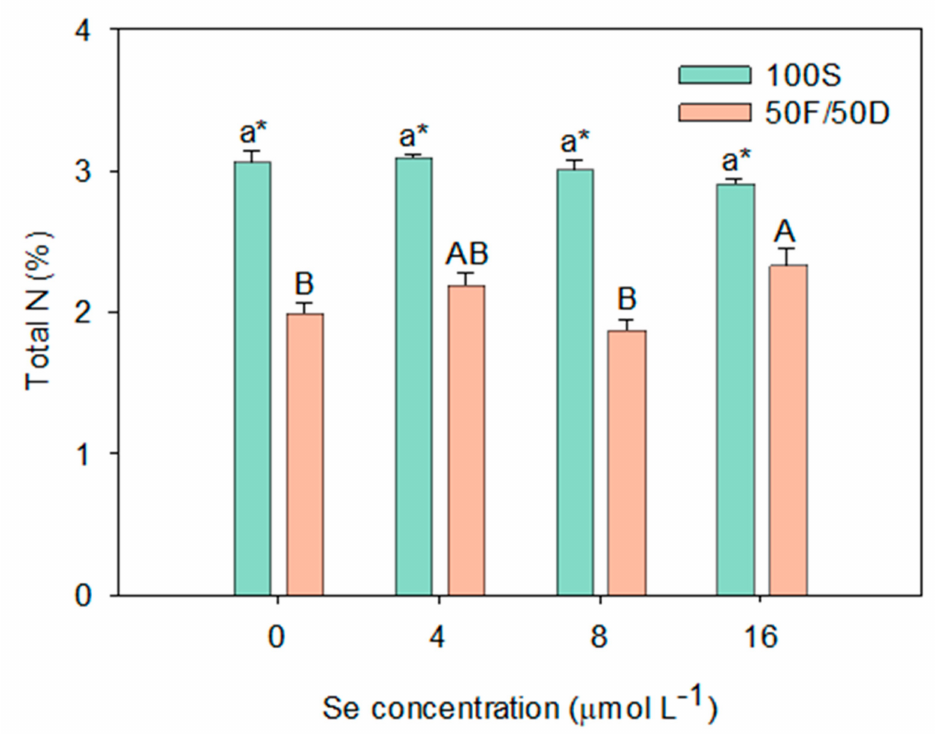
Figure 3. Effects of different selenium concentrations (0, 4, 8, and 16 µ moles L − 1 ) and two types of irrigation water (100S or 50F/50D) on total nitrogen in lettuce. The data are presented as the treatment means ( n = 6). Different lower-case letters indicate significant ( p ≤ 0.05) differences between different dosages of selenium combined with the 100S treatment and different capital letters indicate significant ( p ≤ 0.05) differences between different dosages of selenium combined with the 50F/50D treatment. * denotes significant differences ( p ≤ 0.05) between plants submitted to 100S treatment and those irrigated with 50F/50D for the same Se